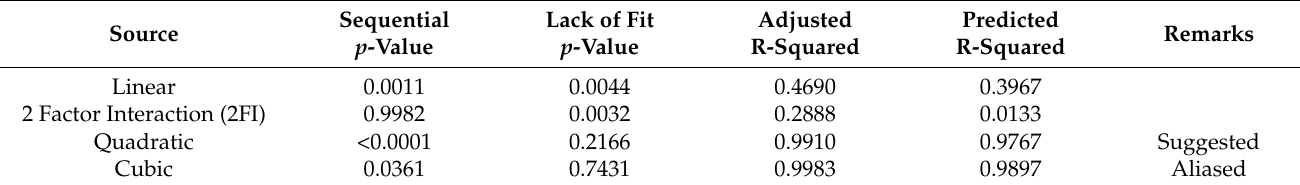
Table 4. Fit summary table for response, bio-oil